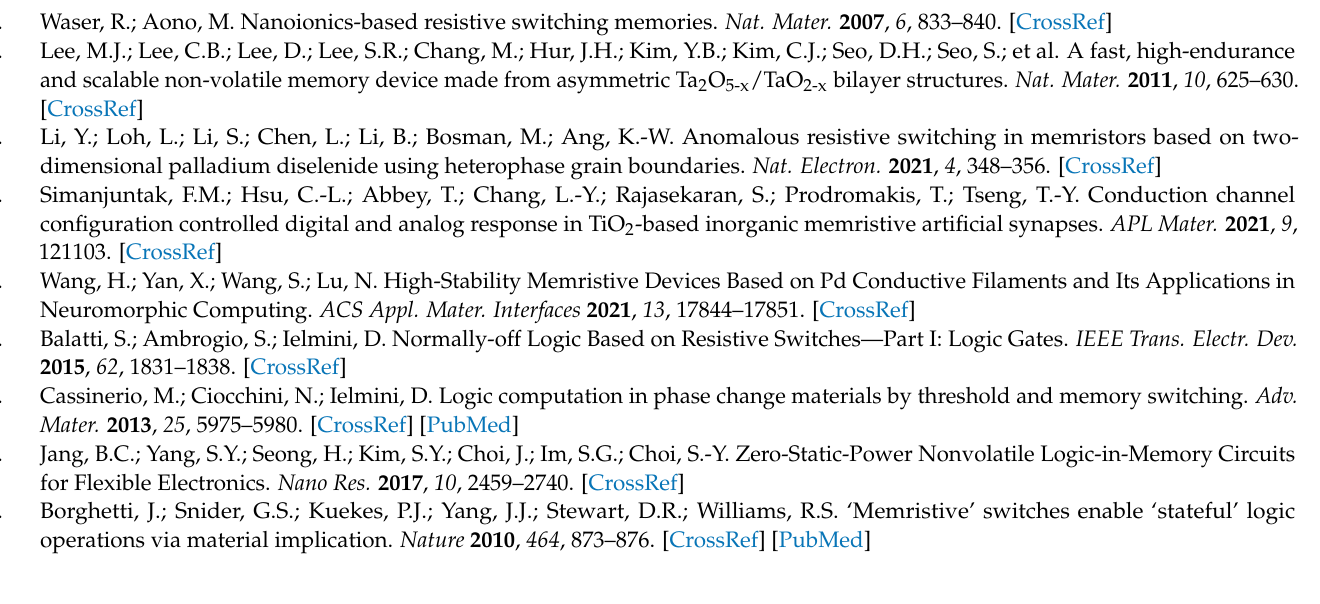
a-ITZO film; Figure S2: Linear plot of I-V characteristics of a-ITZO-selector with and without oxygen plasma treatment; Figure S3: AMF image of oxygen plasma traeted a-ITZO film with (a) 15 min and (d) 20 min at 100 W; Figure S4: Calculated SET voltage window with and without selector device as a function of array